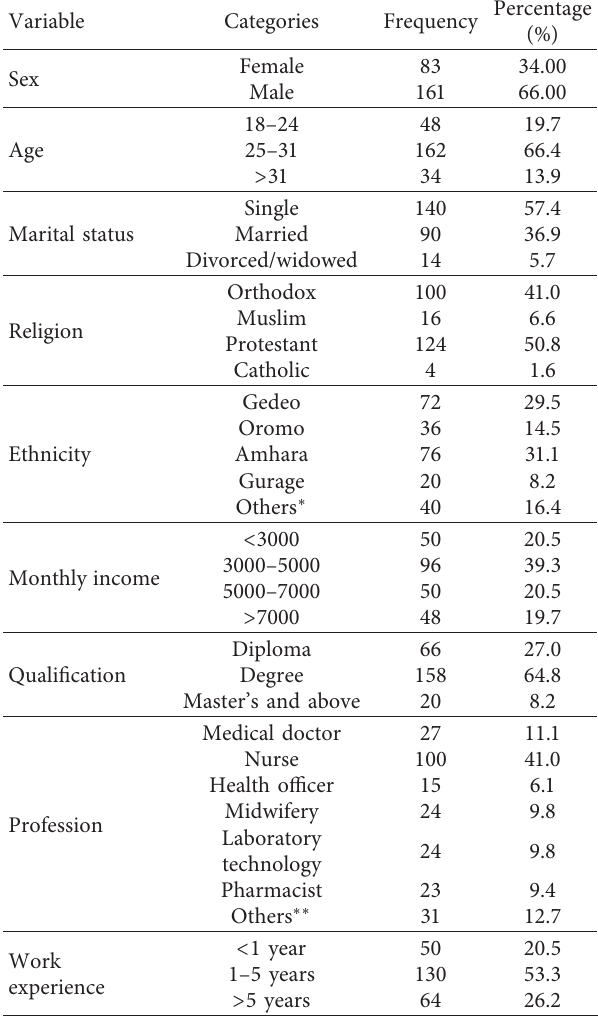
Table 1: Sociodemographic characteristics of respondents in